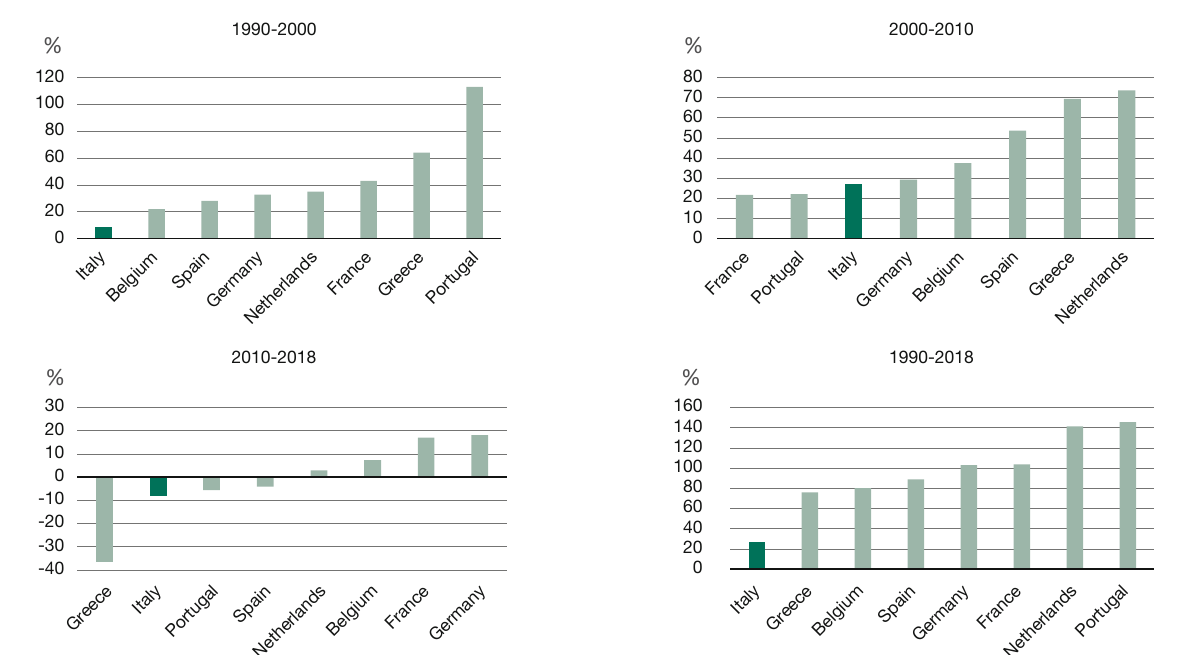
Figure 3 Percentage change in government and compulsory health care expenditure per capita in selected countries constant euros